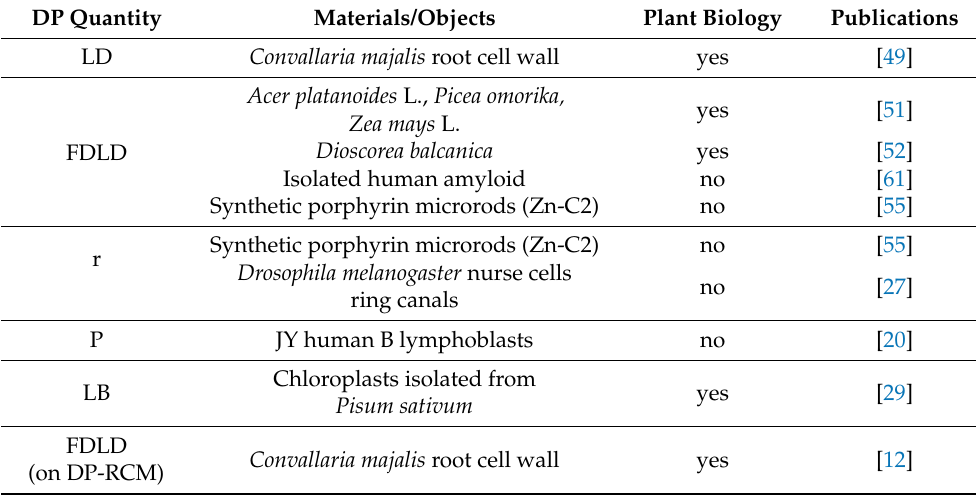
Table 2. An overview of recent DP-LSM and DP-RCM applications on different materials, and related